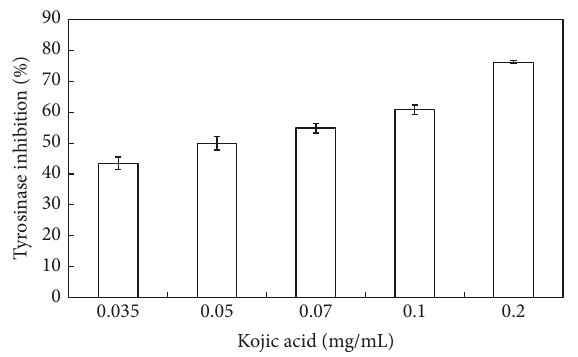
Figure2:Effectofthekojicacidconcentrationoninhibitionoftyro- sinase.